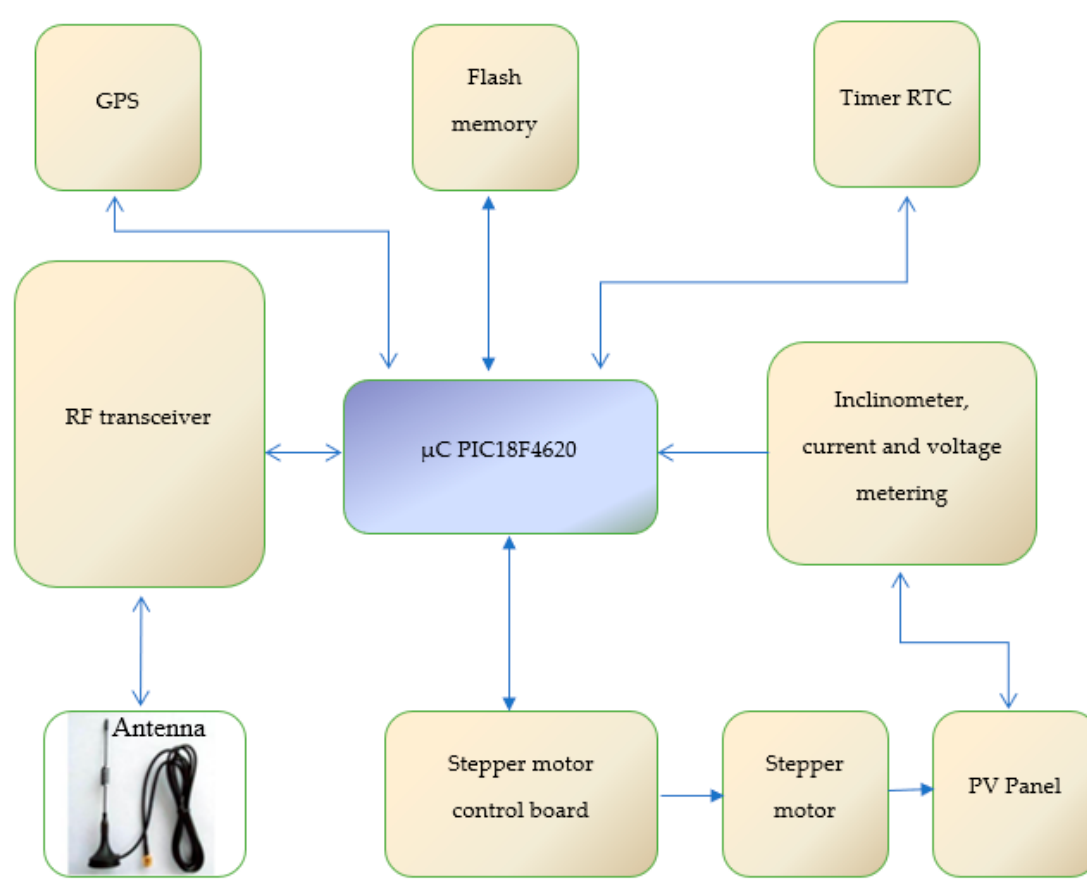
Figure 2. The solar tracker module with the microcontroller in the center of the tasks.